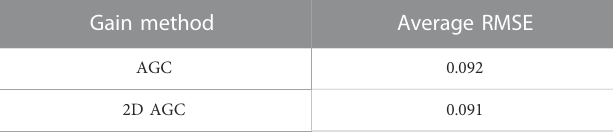
TABLE 2 In fl uence of the gain settings on denoising